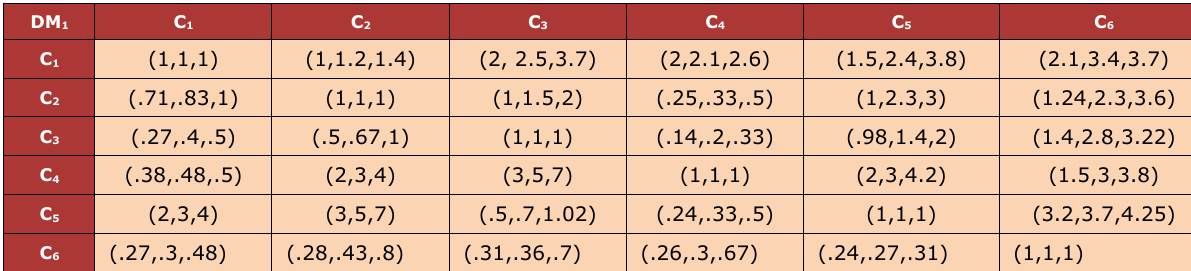
Table 2. Pair-wise comparison of first decision maker